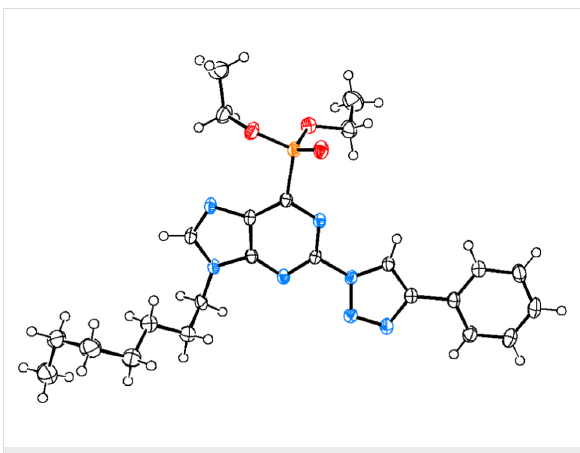
Figure 2: Single-crystal X-ray analysis of diethyl (9-heptyl-2-(4-phenyl- 1 H -1,2,3-triazol-1-yl)-9 H -purin-6-yl)phosphonate ( 4d ).